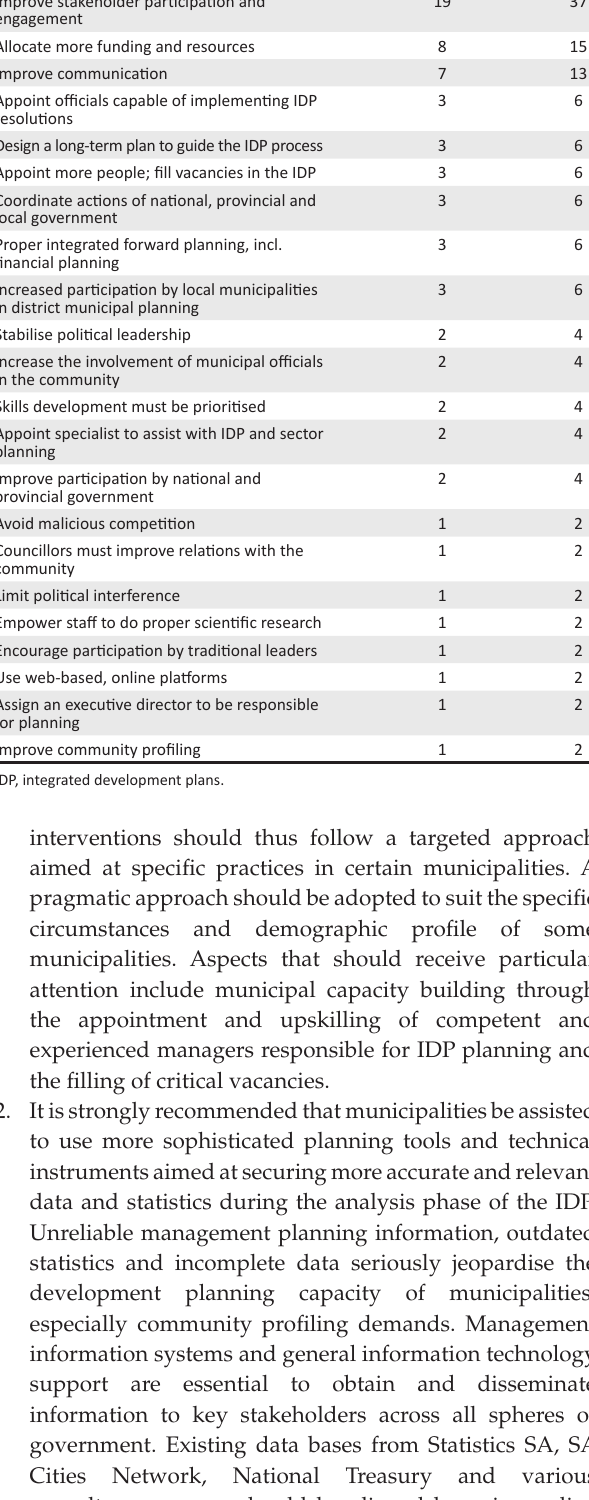
TABLE 7: Recommendations to improve integrated development plans praxis.